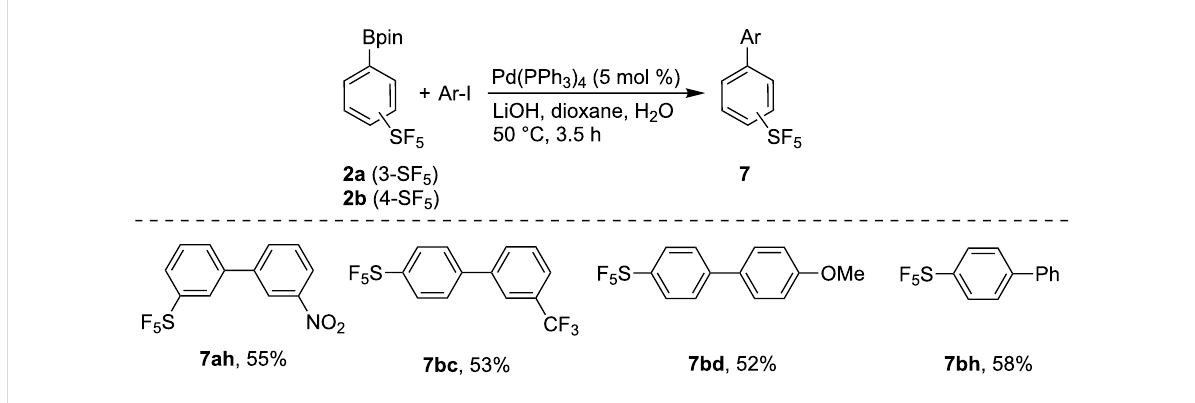
Scheme 4: Suzuki–Miyaura reaction of boronates 2a and 2b with aryl iodides. Reaction conditions: 2 (1 mmol), ArI (1.1 mmol), Pd(PPh 3 ) 4 (5 mol %), LiOH·H